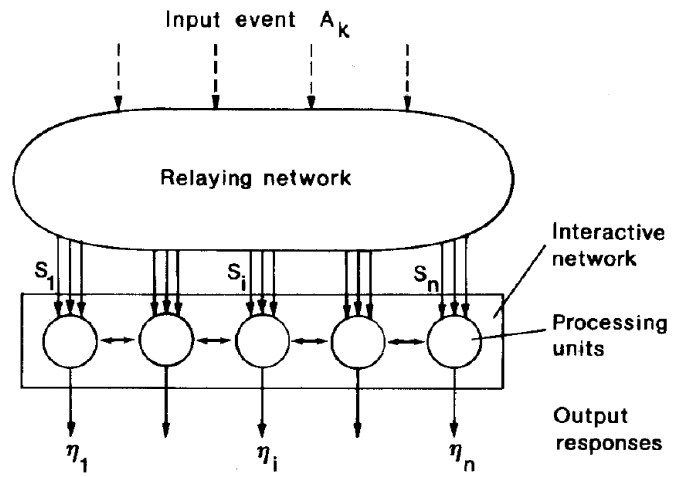
Figure 1. Illustration of a system that implements ordered mappings. Source: (Kohonen 1982). Sets of sensory signals S i distributed to each processor unit i may be non-identical, and the number of signals in each Si may be different; however, these signals are consid- ered coherent in the sense that they are clearly determined by the same events A k . Suppose that events A k can be arranged in some metric or topological way so that A 1 R A 2 R A 3 R …, where R stands for general arrangement relationship that is transitive (the above means e.g., A 1 R A 3 ). Next, the processor units produce output responses to events with scalar val- ues η i ( A 1 ), η i ( A 2 ), … The system according to Figure 1 is intended to implement one-dimensional ordered mapping if for i 1 > i 2 > i 3 > …, η i 1 ( A 1 ) = max j { η j (A 1 ) | j = 1 , 2 , …, η } η i 2 ( A 2 ) = max j { η j (A 2 ) | j = 1 , 2 , …, η } η i 3 ( A 3 ) = max j { η j (A 3 ) | j = 1, 2 , …, η } The above definition is easily generalizable for two or more large arrays of processor units; in this case, topological order, induced by more than one ordered relationship with respect to different attributes, shall be definable for events A k. On the other hand, the field topology is simply defined by the definition of the neighbors of each unit. If the unit with the maximum response to a specific event is treated as an image of that event, then the mapping is considered ordered if the topological relationships of images and events are similar (Kohonen, 1982). Creation of topological maps in a two-dimensional field with the same inputs to all units Figure 2 defines a rectangular array of processor drives. In the first experiment, the transmission network was neglected, and the same set of input signals was connected to all units { ξ 1, ξ 2 ,…, ξ n }. In accordance with the notations used in mathematical system the- ory, this set of signals was expressed as a column vector x = [ ξ 1, ξ 2 , … , ξ n ] T ∈ R n where T indicates transposition. Unit i shall have input balances or parameters μ i 1 , μ i 2 , …, μ in , ex- pressible as an additional vector m i = [ μ i 1 , μ i 2 ,…, μ in ] T ∈ R n . The unit shall constitute a dis- criminatory function: